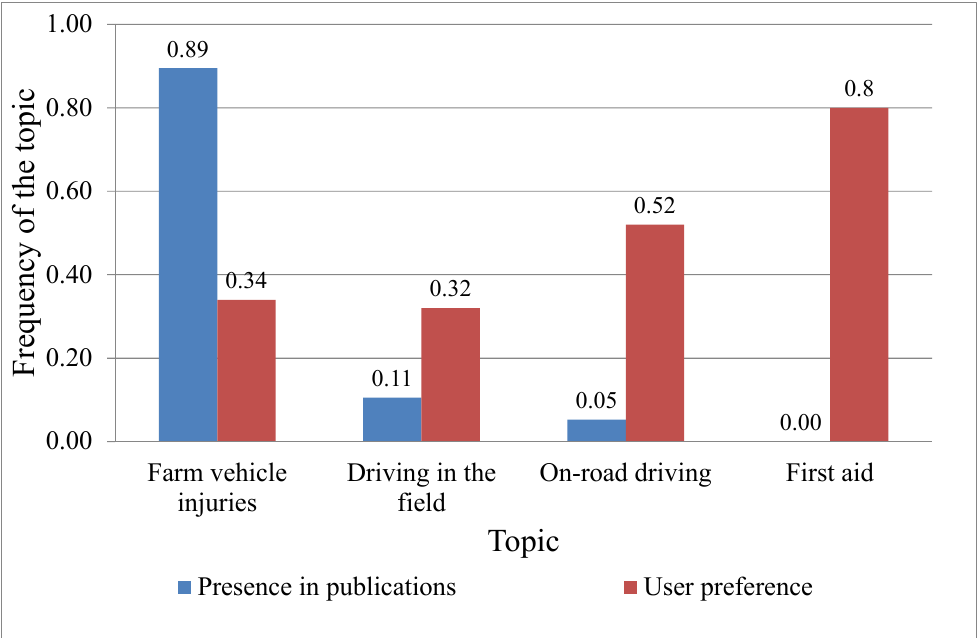
Figure 4. Frequencies of the topics dealt with in the sample of the 19 analysed publications (blue) and the normalized average scores expressed by the 19 operators (red) in the Action category.